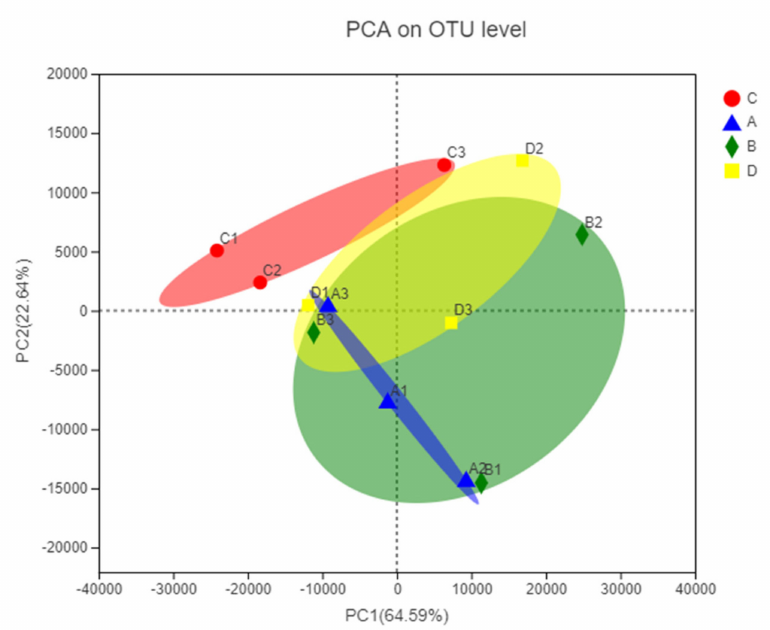
Figure 7. Principal coordinate analysis (PCA) on OTU level among each